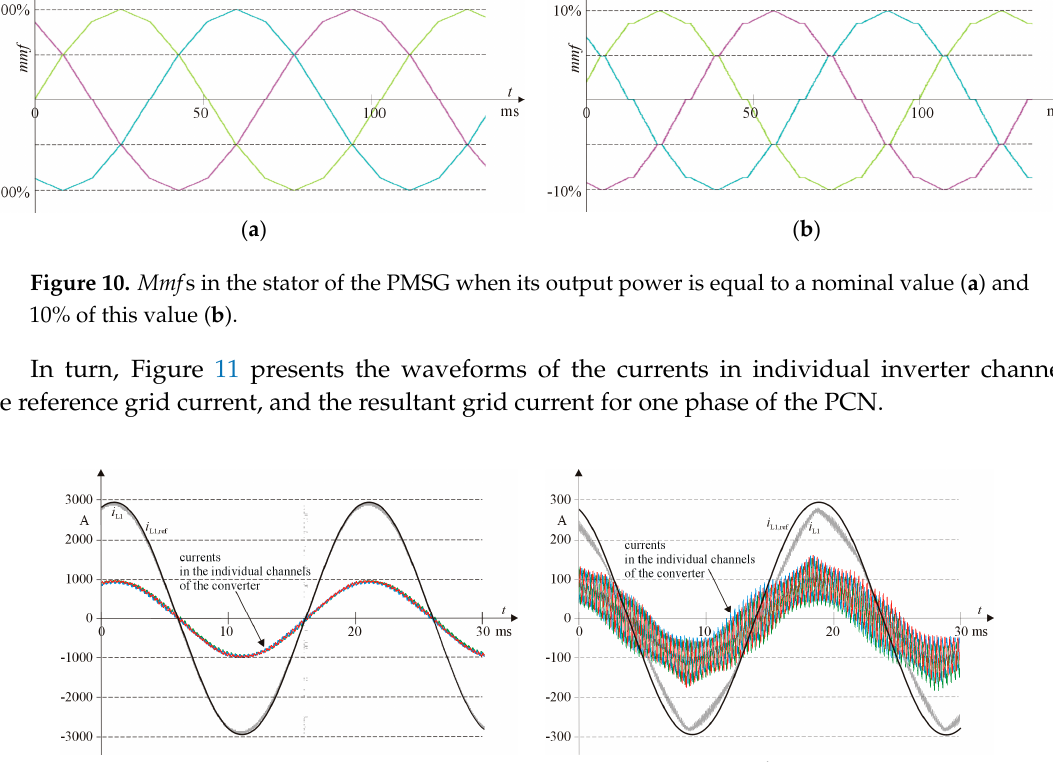
and resultant power grid current (grey)—for one phase of PCN—when its output power is equal to the